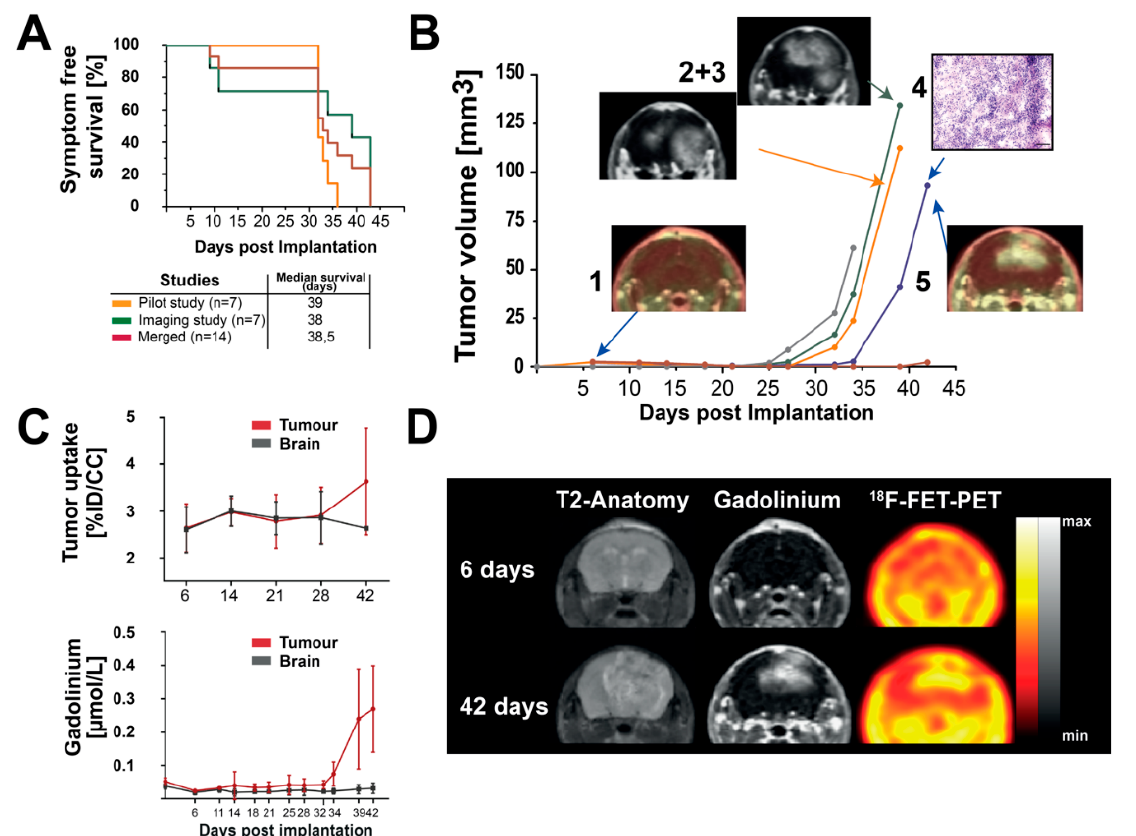
Figure 3. ( A ): Kaplan–Meier plots of symptom-free survival of the longitudinal observational study with and without MRI and FET-PET measurements (yellow and green curve). The red curve repre- sents entire animal studies. No statistically significant differences in Log-Rank test and Tukey–Kramer post hoc test were observed. ( B ) Longitudinal tumor volume development: (1) representative FET-PET image day 7; (2) and (3) representative MRI images of day 39 PTI (post tumor initiation) of two animals showing glioma-like gadolinium enhancement in the final stage of the disease; (4) representative H&E staining showing glioma-like histologic features in the region of the previously occurred gadolinium enhancement (scale bar is 50 µm); (5) representative FET-PET image, showing FET uptake in tumor regions at day 42 PTI. ( C ) (1) Analysis of [ 18 F]FET uptake in five representative imaged animals. (2) Analysis of longitudinal gadolinium uptake in tumor regions and normal brain regions. Error bars represent standard deviation (SD). ( D ): Longitudinal MRI and FET-PET images of one representative animal. Color bars as the reference of gadolinium and [ 18 F]FET uptake are shown. We performed Hematoxylin and Eosin (H&E) staining for the histological confirmation of tumor formation in post-experimental brain tissue. Additionally, immunohistochemistry for the proliferation marker Ki67 as well as endothelial marker CD31 were executed